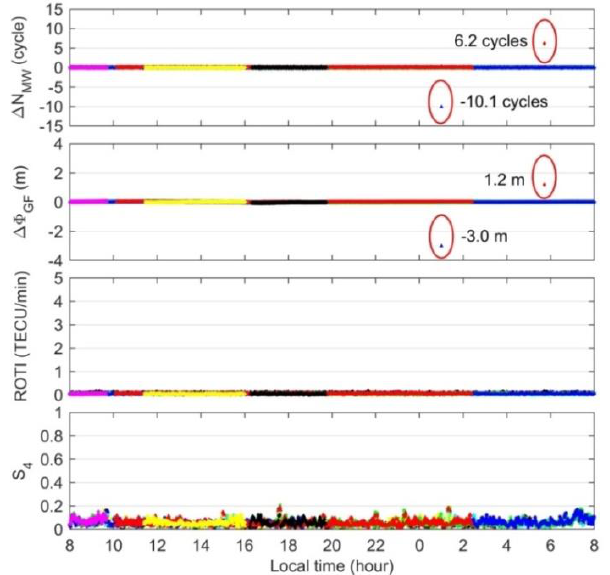
Figure 7. Example of no scintillation occurrence but with cycle-slips using the BDS data collected at HKST station on 22 February 2016.